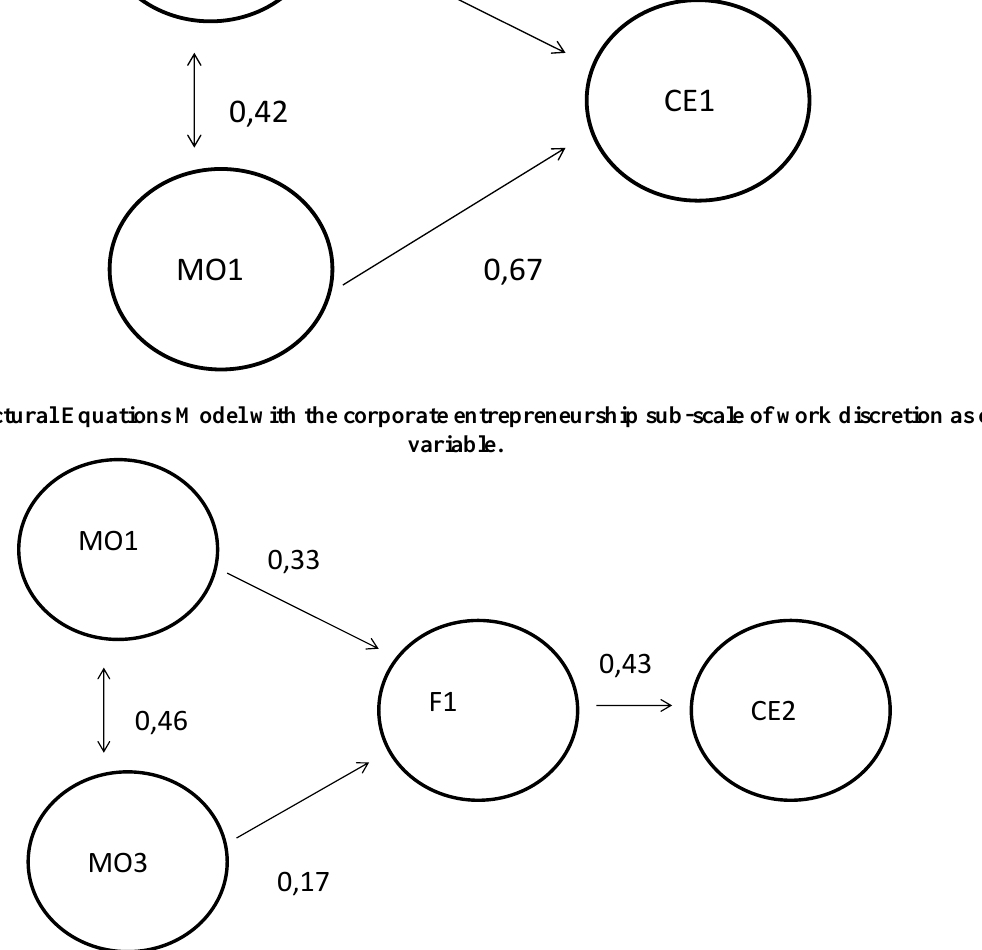
Figure 3: Structural Equations Model with the corporate entrepreneurship sub-scale of management support as outcome